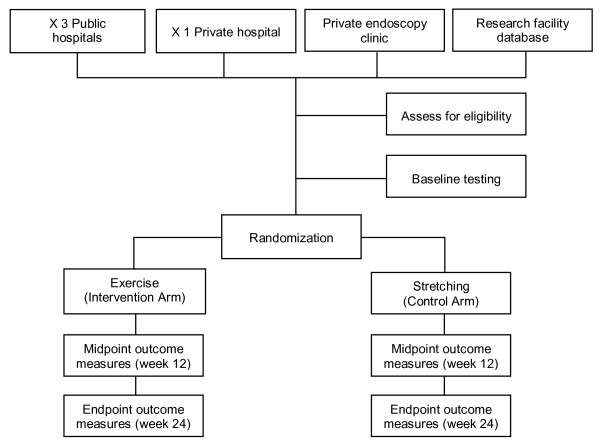
CONSORT diagram.